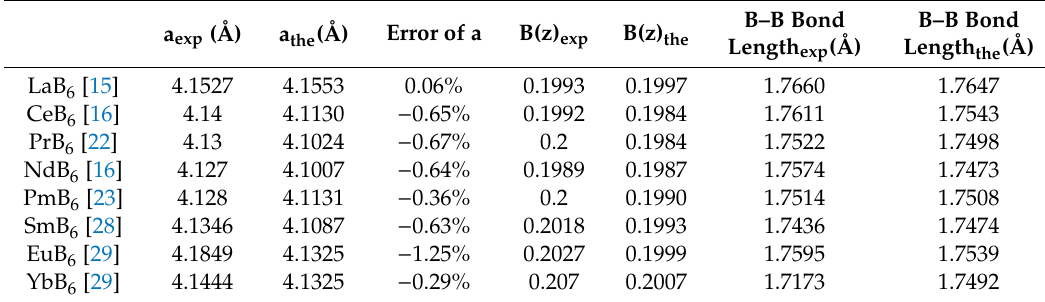
Table 1. Experimental (exp) and theoretical (the) lattice parameters. The rare-earth hexaboride crystalizes in a bcc-like structure with space group of Pm3̅m (No. 221), in which metal ions are located at the Wyckoff position 1a(0,0,0) and octahedral B 6 at the Wyckoff position 6f (1/2,1/2,z). The subscripts “exp” and “the” indicate experimental and theoretical results, respectively.